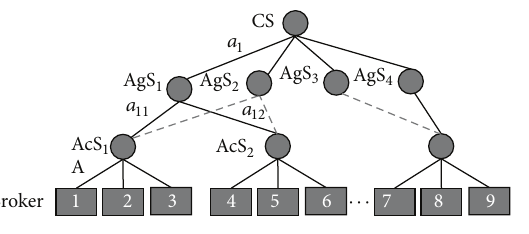
Figure 3: Network topology.